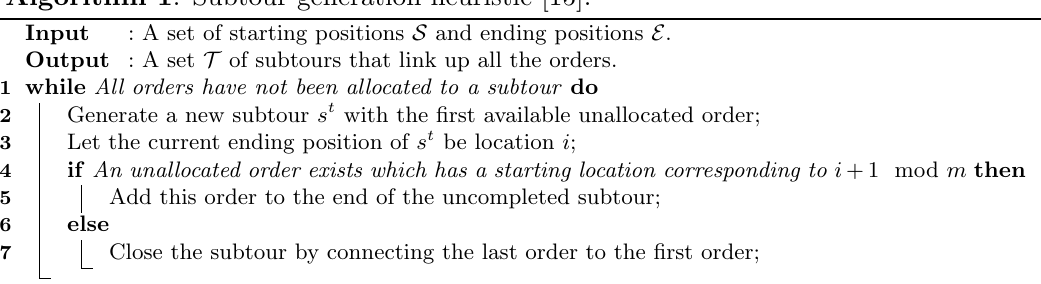
Algorithm 1 : Subtour generation heuristic